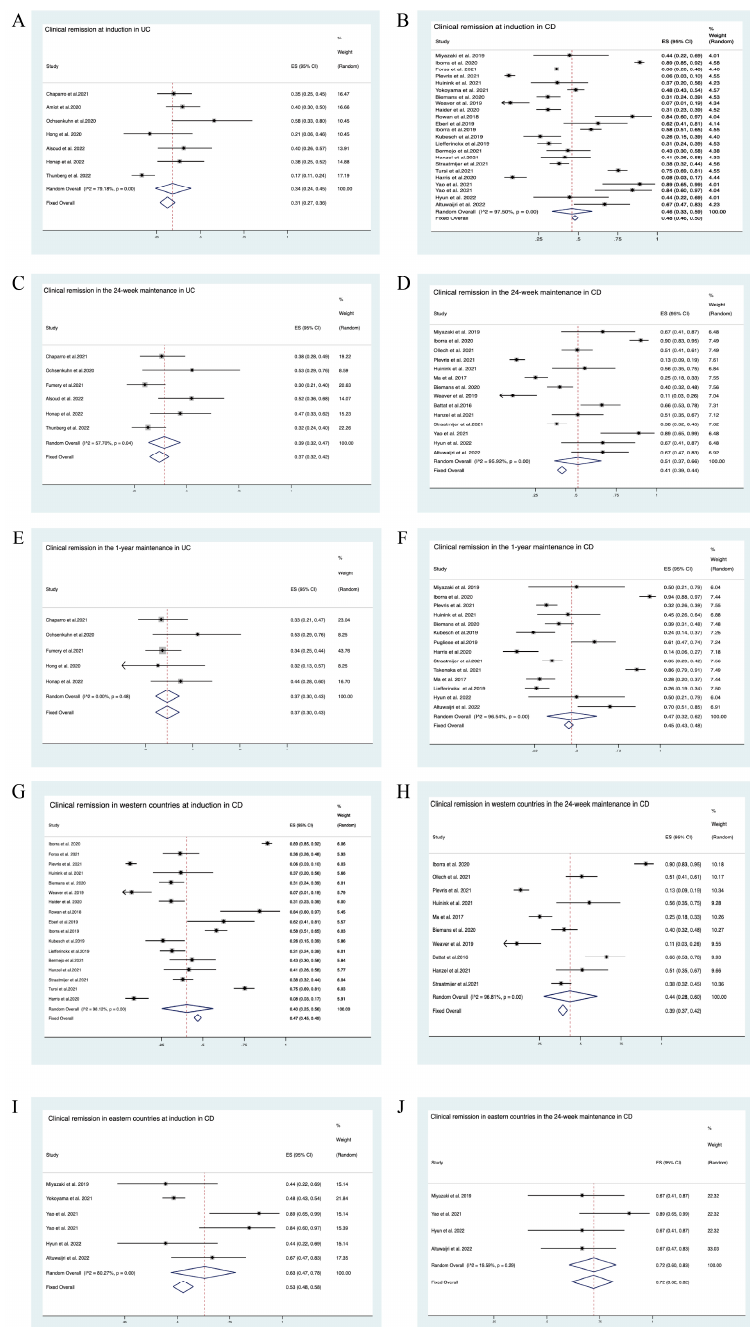
Figure 2. Meta-analysis of studies that assessed the clinical remission at induction and during the 24-week and 1-year maintenance periods. The size of each square represents the weight assigned to each study based on sample size. Error bars represent 95% CIs. Diamonds represent the point estimate of the average study rates; the lateral tips of the diamonds denote 95% CIs. ( A ) Clinical remission at induction in UC. ( B ) Clinical remission at induction in CD. ( C ) Clinical remission at 24 weeks of maintenance in UC. ( D ) Clinical remission at 24 weeks of maintenance in CD. ( E ) Clinical remission at the end of the 1-year maintenance period in UC. ( F ) Clinical remission at the end of the 1-year maintenance period in CD. ( G ) Clinical remission in Western countries at induction in CD. ( H ) Clinical remission in Western countries at 24 weeks in CD. ( I ) Clinical remission in Eastern countries at induction in CD. ( J ) Clinical remission in Eastern countries at 24 weeks in